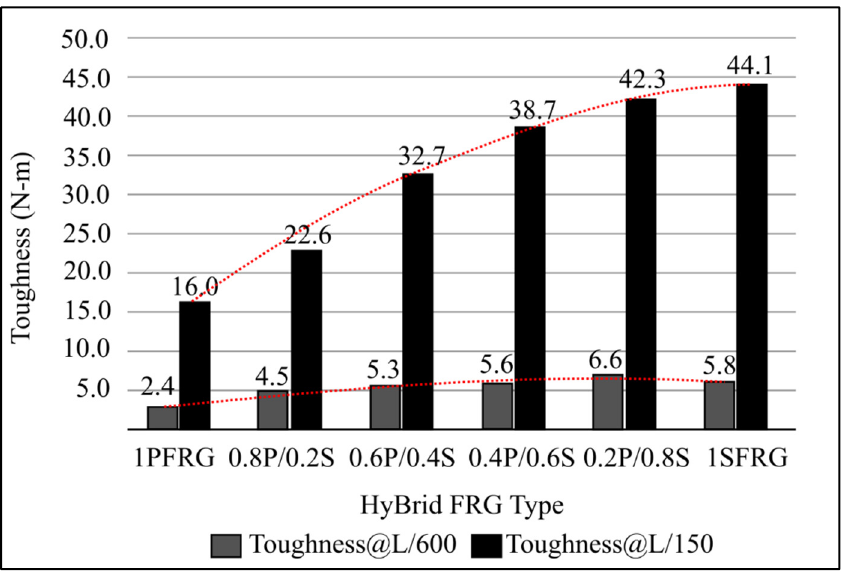
Figure 5. Toughness of r-HyFRG [5].